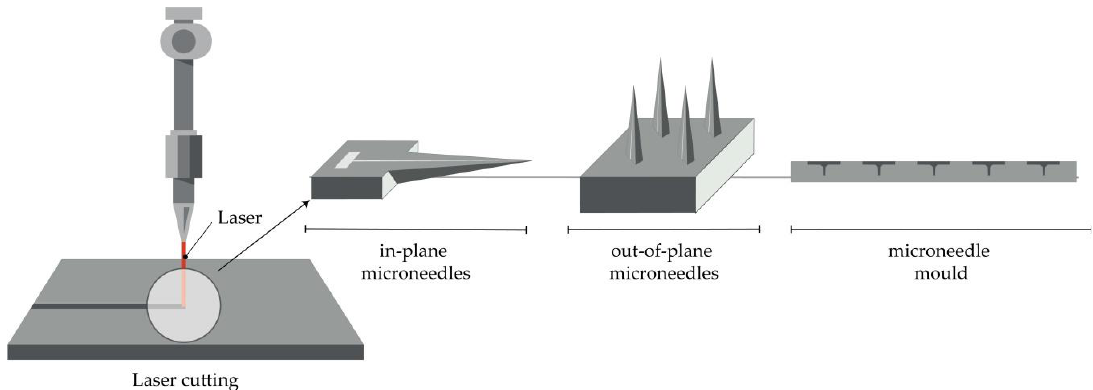
Figure 4. Principle of manufacturing of MNs (in-plane and out-of-plane) and MN molds by the laser cutting.